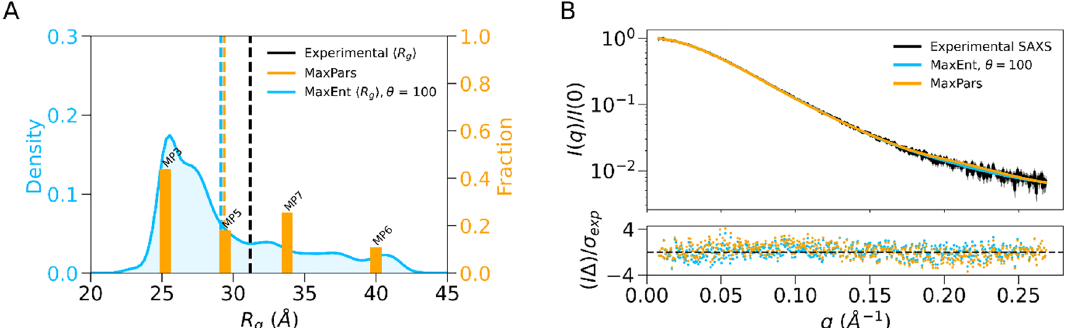
Figure 6. Comparison of MaxPars and MaxEnt ensembles of the HOIP RBR domain. ( A ) MaxPars and MaxEnt are visualised as discrete and continuous R g distributions, respectively. The average values are denoted as vertical dashed lines. ( B ) Agreement between experimental and ensemble scattering profiles. The experimental, MaxEnt and MaxPars scattering profiles are coloured black, light blue and orange, respectively. The